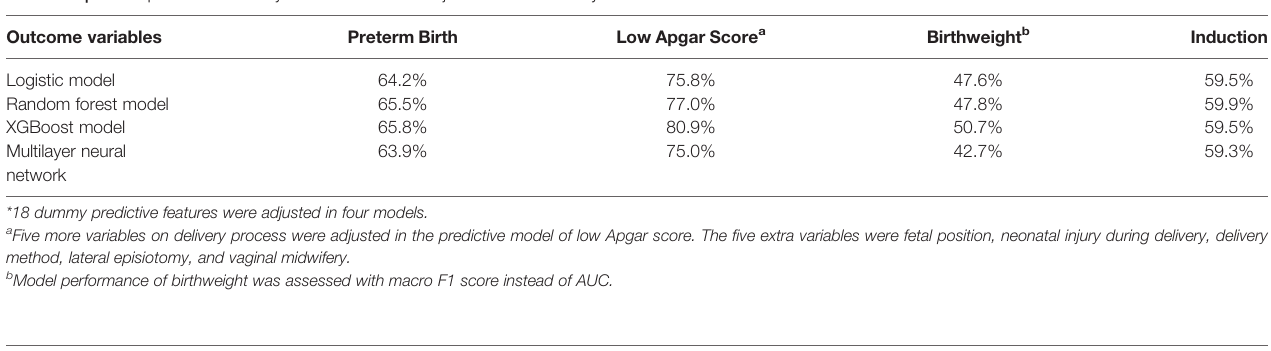
TABLE 2 | Model performance of synthetic data from subjects in the fi rst analysis.